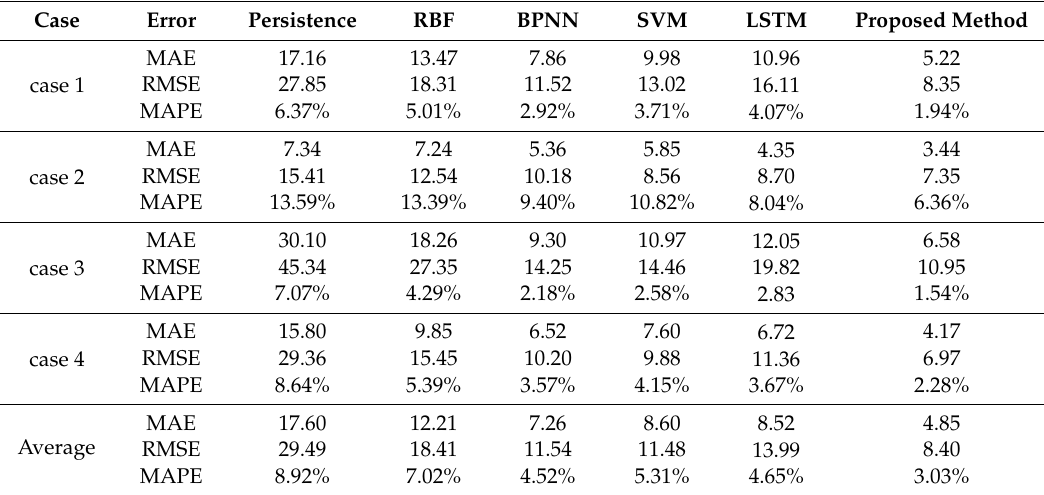
Table 1. Performance evaluation for the 15-min ahead forecasting.